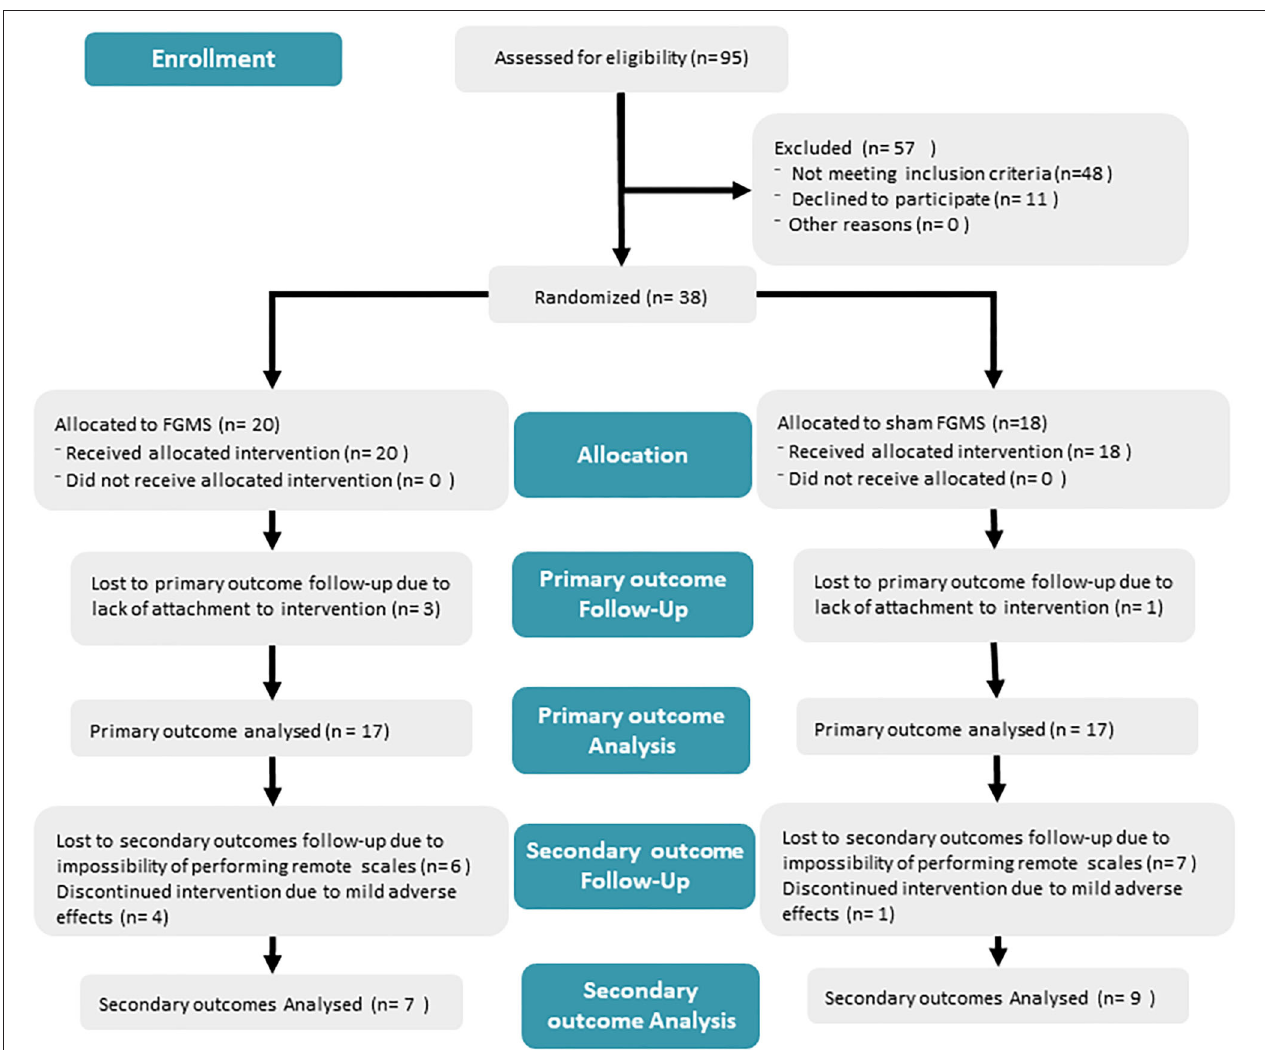
FIGURE 2 | Diagram of the method from recruitment to analysis. The diagram explains the number of subjects in each step and the population per group.